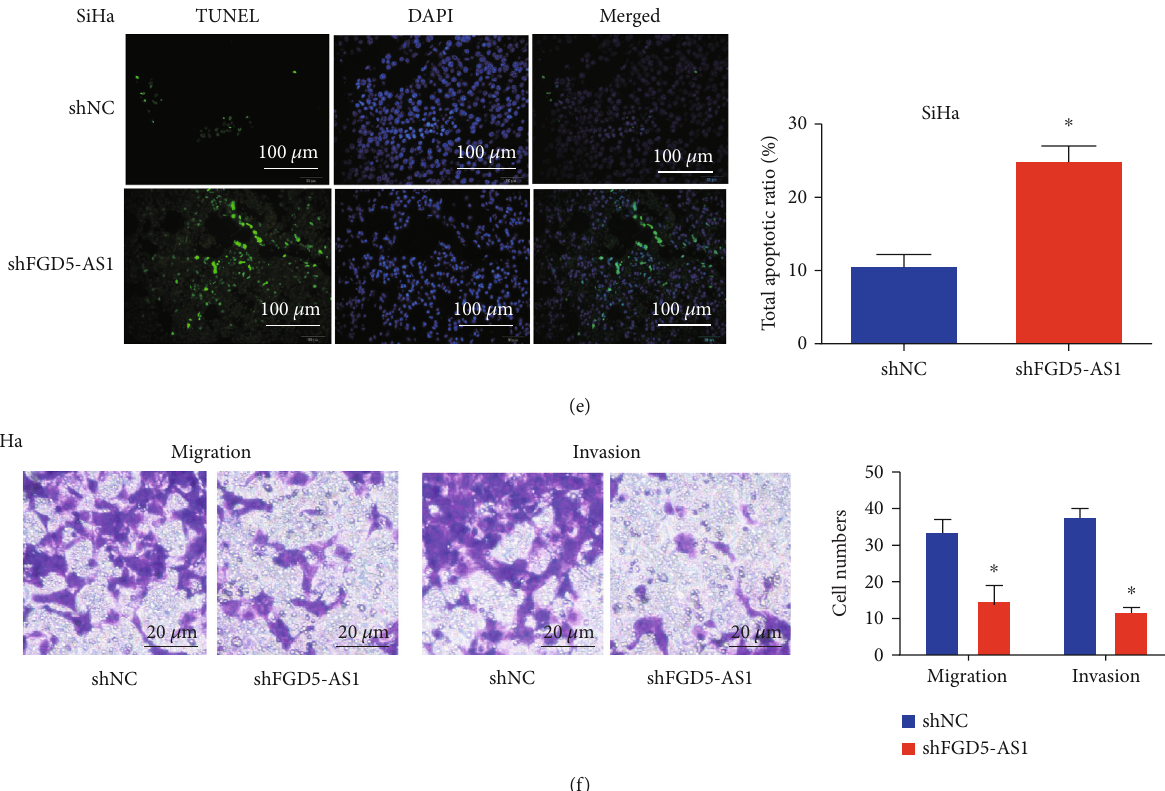
Figure 2: E ff ects of FGD5-AS1 on cervical cancer cell aggressiveness. (a) FGD5-AS1 expression in SiHa cells. FGD5-AS1 knockdown was generated in the SiHa cells by transfection of shFGD5-AS1. The transfection e ffi ciency was validated by real-time PCR. (b, c) BST2 mRNA and protein expression in SiHa cells. (d) Cell viability by CCK8 assay. (e) Cell apoptosis by TUNEL assay. (f) Migration and invasion capacity using Transwell assay. ∗ P < 0 : 05 . shNC shRNA: negative control. Three independent assays were carried